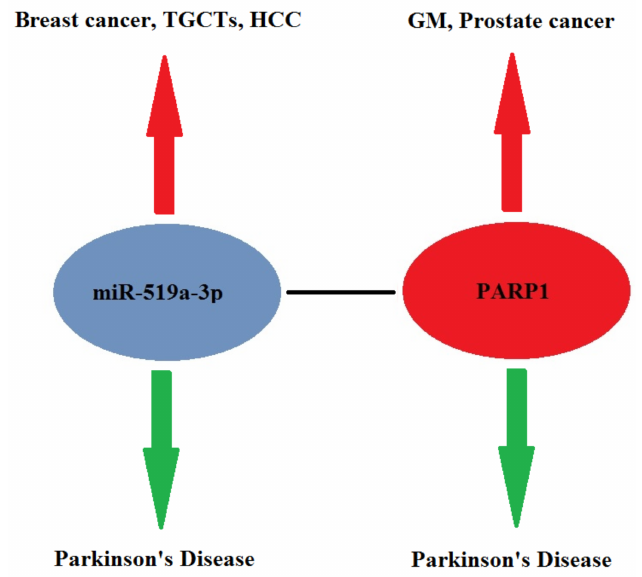
Figure 4. Examples of inverse comorbidity between tumors and Parkinson’s disease in which the miR-519a-3p and PARP1 gene play an important role. TGCTs, testicular germ cell tumors; HCC, hepatocellular carcinoma; GM, glioblastoma multiforme. Red arrow, upregulated; green arrow,